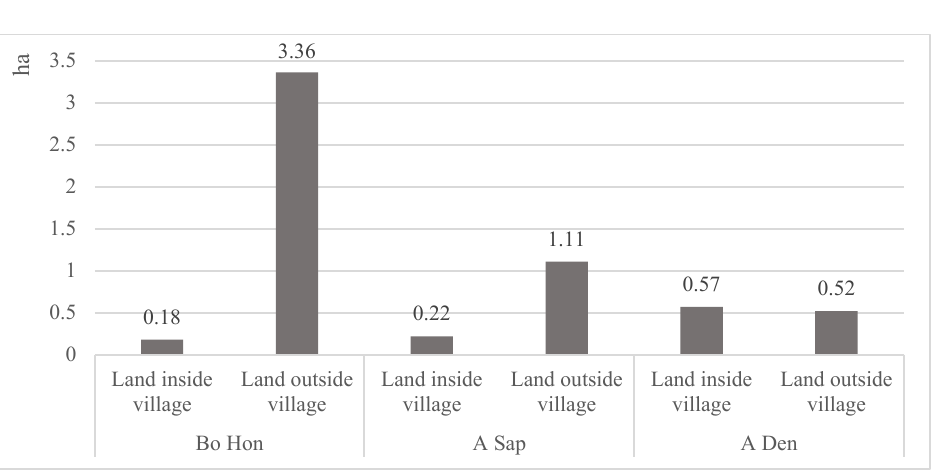
Figure 6. The purposes of crop produce and livestock by villages.